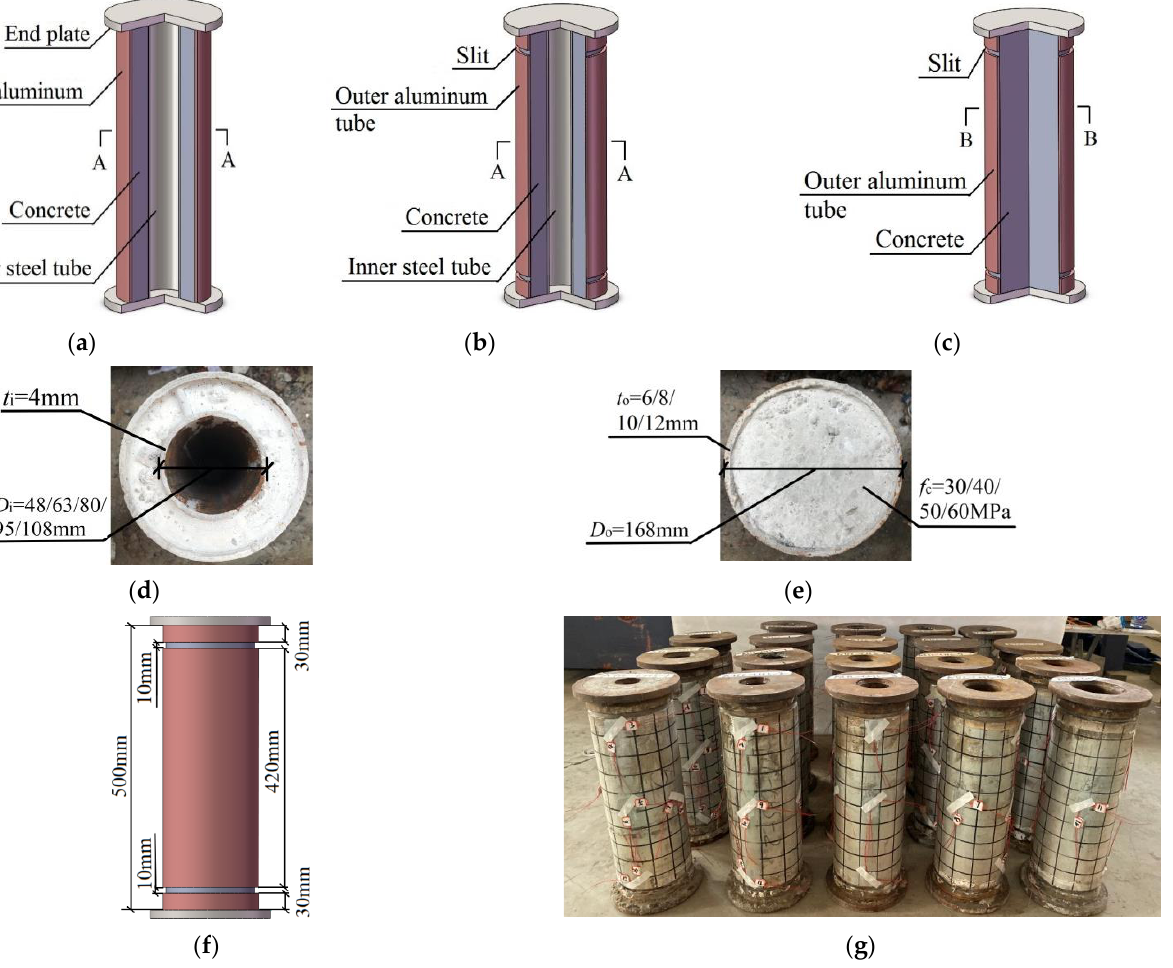
Figure 3. Specimen details.( a ) CFAT-CHS columns; ( b ) ATCC-CHS columns; ( c ) ATCC columns; ( d ) A-A cross section; ( e ) B-B cross section; ( f )specimen dimensions; ( g ) photos of specimens.